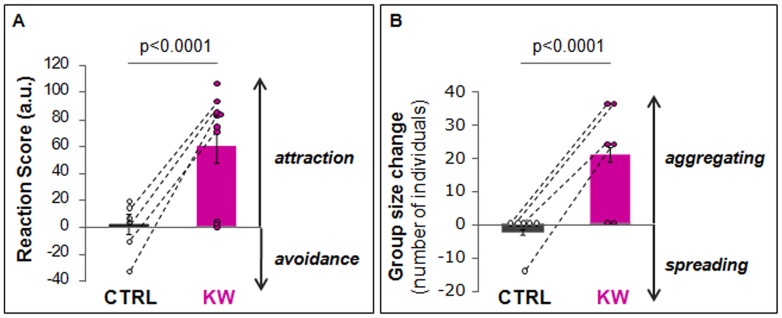
Response of tagged long-finned pilot whales to KW and CTRL playbacks.(A) Reaction scores for KW playbacks (N = 5 whales tested twice, n = 10 trials) and CTRL playbacks (N = 3 whales tested twice, n = 6 trials). Positive values: attraction towards the sound source; negative values: avoidance. Dashed lines link the reaction scores of the same subject. (B) Change of group size during KW and CTRL playbacks (for each stimulus type: N = 3 individuals tested twice, n = 6 trials). Positive values: whales aggregating around tagged animal; negative values: whales spreading. Error bars give mean ± SEM.